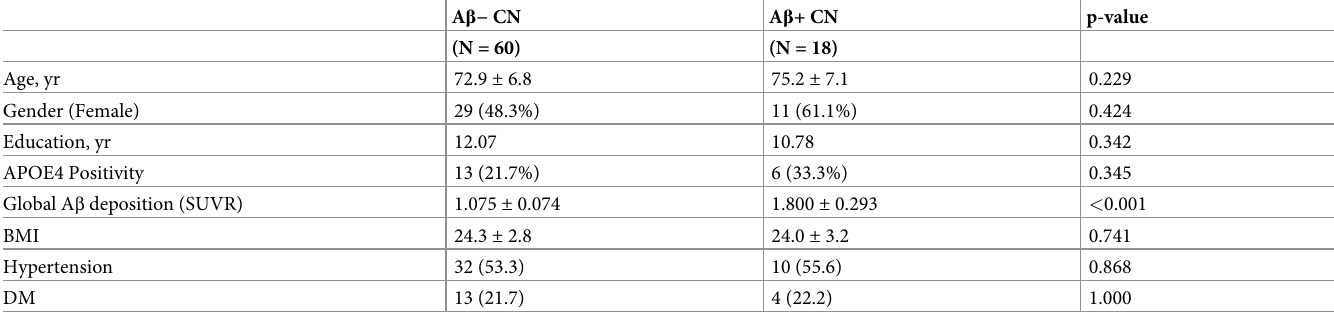
Table 1. Participant characteristics.